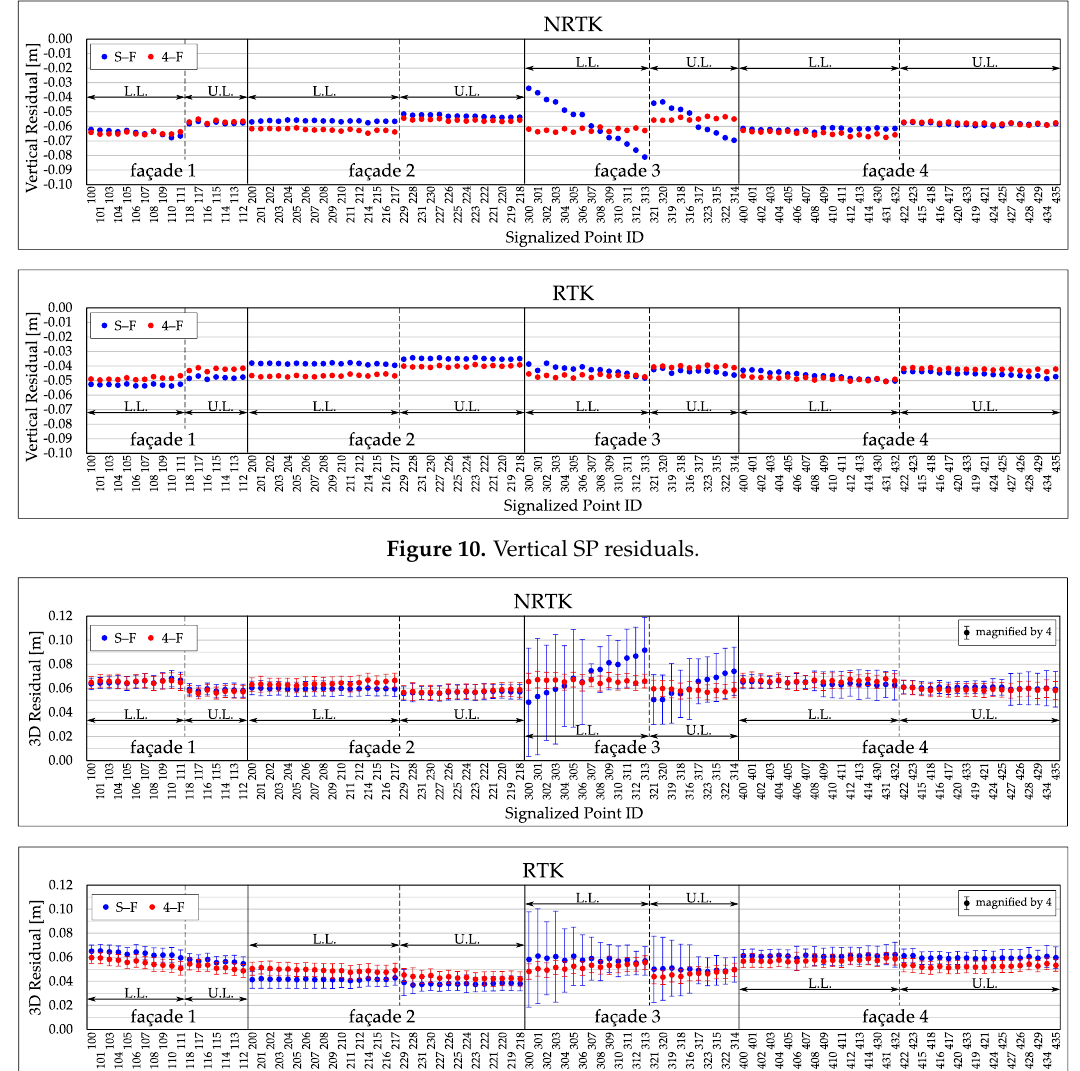
Figure 9. Horizontal SP residuals.